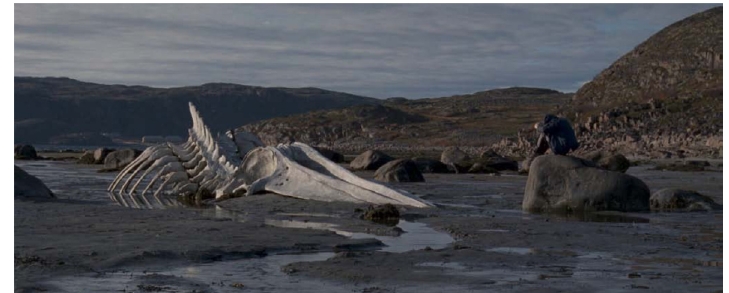
Figure 11. Leviathan (2014).